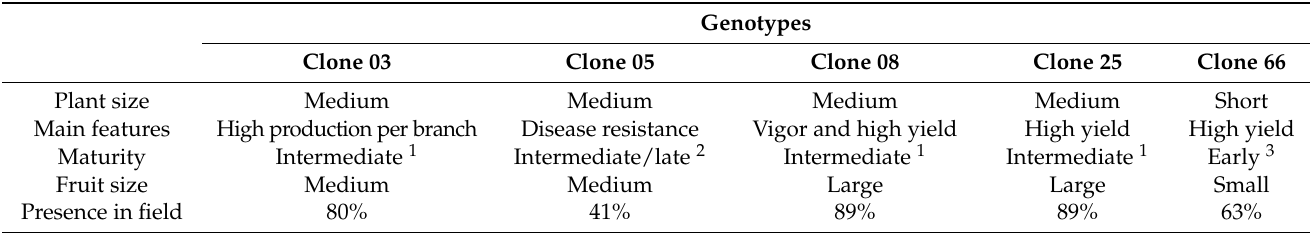
Table 1. Characteristics of the main clones of C. canephora grown in the State of Rond ô nia. Genotypes Clone 03 Clone 05 Clone 08 Clone 25 Clone